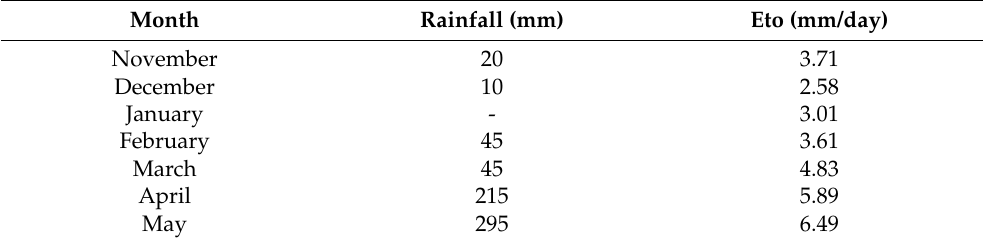
Table 5. Rainfall (mm) and Evapotranspiration (ETo) in mm/day of the experimental plot’s location.